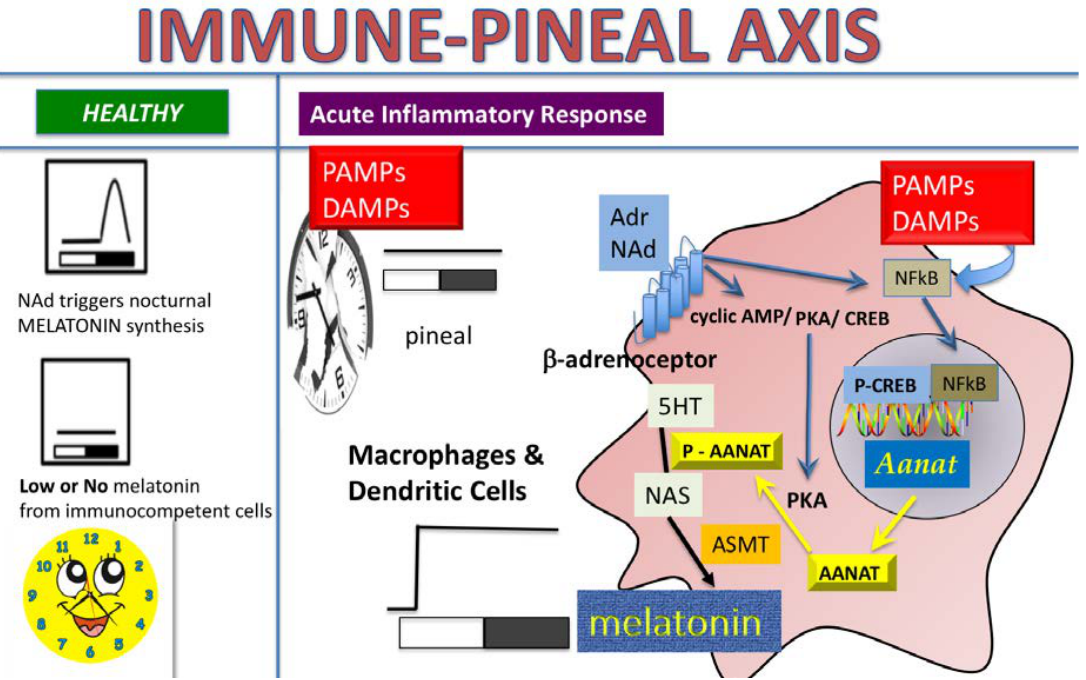
Figure 6. The Immune-Pineal Axis—Catecholamines induce melatonin synthesis in macrophages— Pathogen- and damage-associated molecular patterns (PAMPs and DAMPs), such as lipopolysaccharide (LPS), β -amyloid peptide and the pro-inflammatory cytokine tumor necrosis factor (TNF), block the synthesis of melatonin by pinealocytes. Reduction of nocturnal melatonin surge favors the migration of leukocytes to the site of the lesion. The same PAMPs/DAMPs induce the synthesis of melatonin in macrophages, microglia, and dendritic cells. This switch in melatonin source allows the migration of cells to the site of lesion, where, locally synthesized melatonin plays regulatory roles. Interestingly, activation of NF κ B is the key mechanism for blocking/inducing melatonin synthesis in pinealocytes/macrophages, as it regulates the transcription of the gene coding the enzyme (AA-NAT) that catalyzes the conversion of serotonin in N -acetylserotonin, the immediate precursor of melatonin [4,34]. One of the open questions in this system was whether catecholamines might lead to melatonin synthesis in macrophages/monocytes as it does in the pineal gland. Here we showed that activation of β -adrenoceptors induces the transcription of Aanat in a PKA and NF- κ B dependent manner.